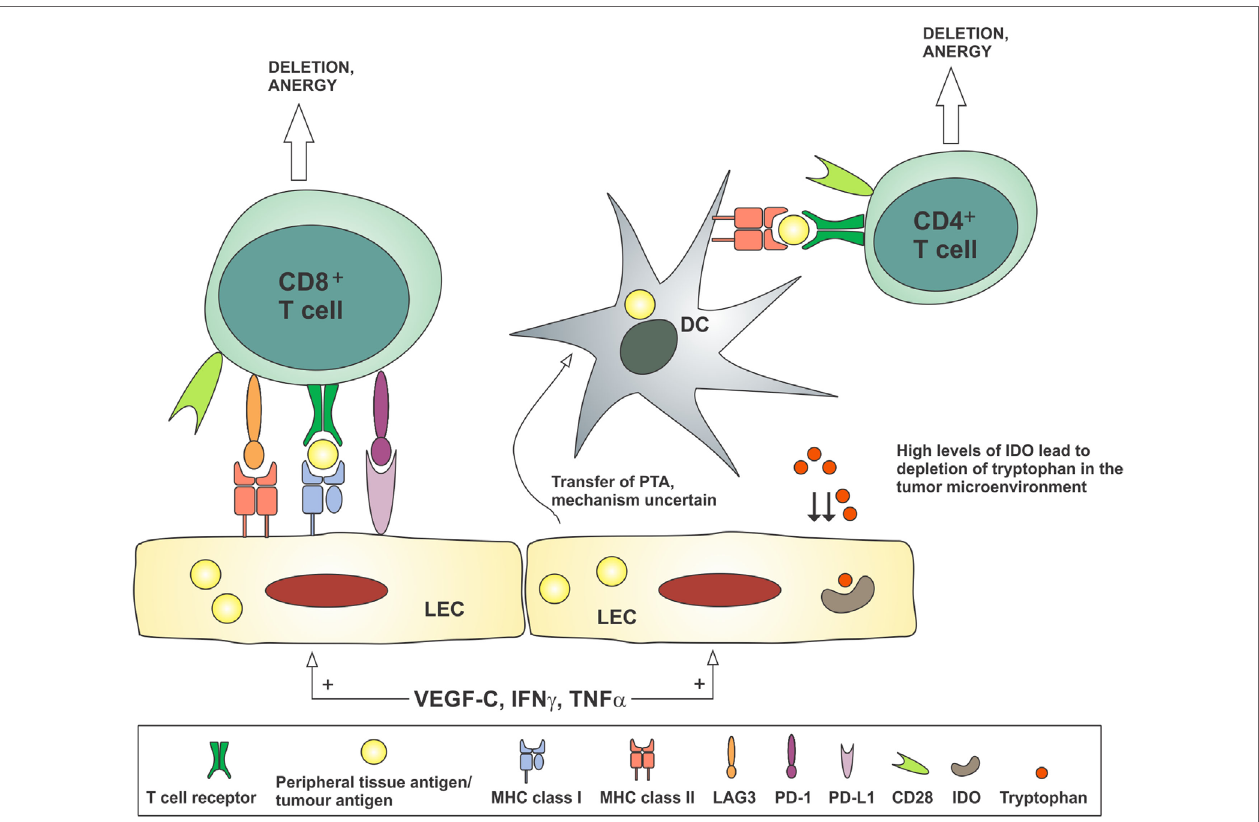
FigURe 4 | Lymphatic endothelial cells may contribute to the development of tolerance to tumor antigens by antigen presentation to CD8 + T cells in the absence of costimulatory molecules such as CD80/CD86, or in the presence of co-inhibitory molecules such as PD-L1 and LAg3 . Peripheral tissue antigens or tumor antigens may be transferred from LECs to dendritic cells, which present these antigens to CD4 + T cells in the absence of costimulatory molecules, thereby inducing anergy. Stimulation of LECs by VEGF-C and inflammatory cytokines TNF α and IFN γ can reduce CD86 expression on dendritic cells and produce IDO, which depletes tryptophan from the microenvironment, thereby preventing the activation of T cells. DC, dendritic cell; IDO, indoleamine 2,3-dioxygenase; IFN γ , interferon-gamma; LEC, lymphatic endothelial cell; PTA, peripheral tissue antigen; TNF α , tumor necrosis factor-alpha; VEGF-C, vascular endothelial growth